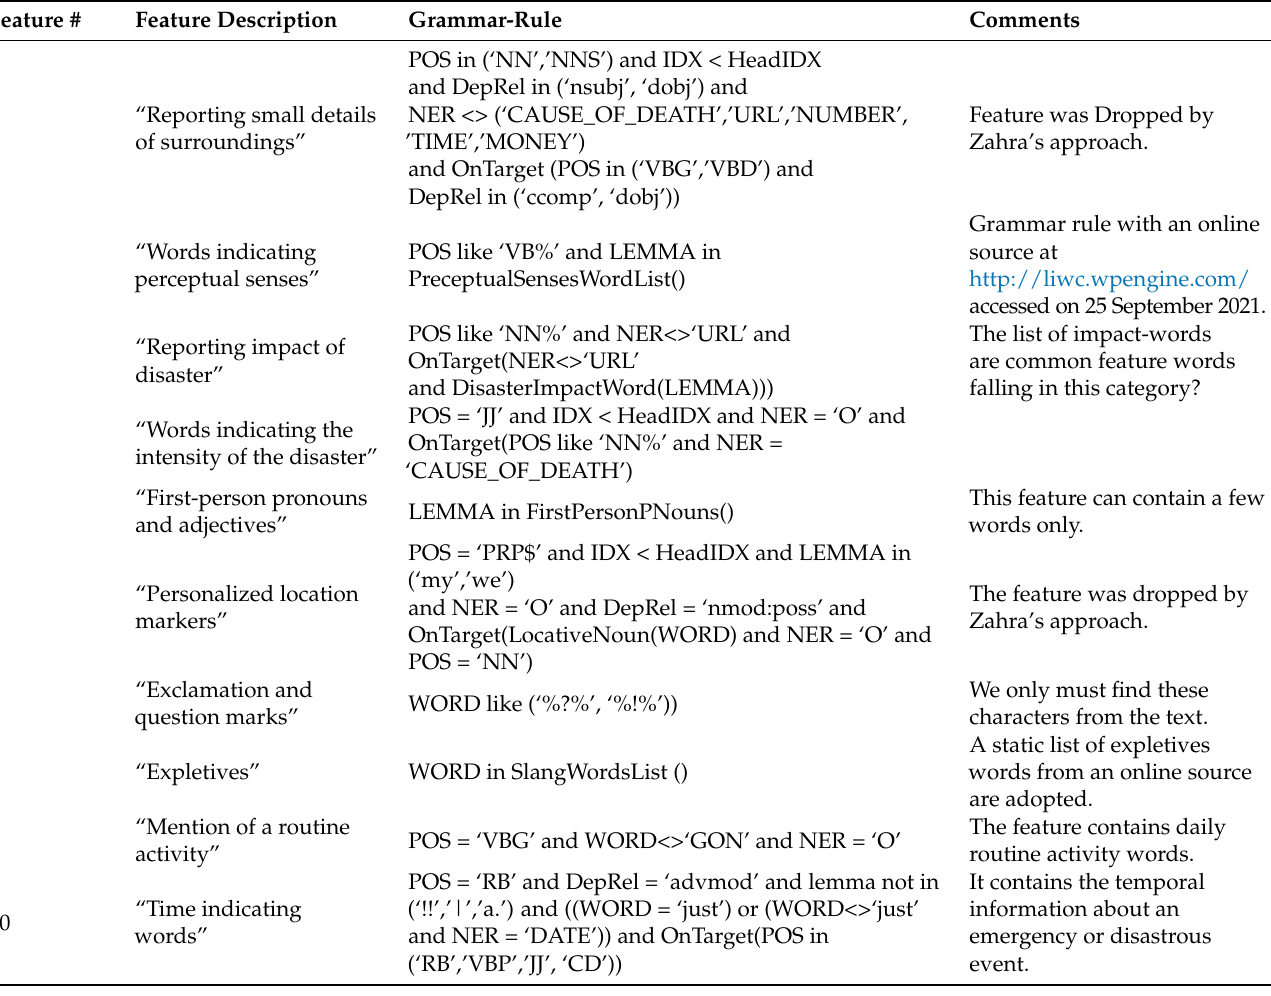
Table 6. Grammar-Rules for Extraction of